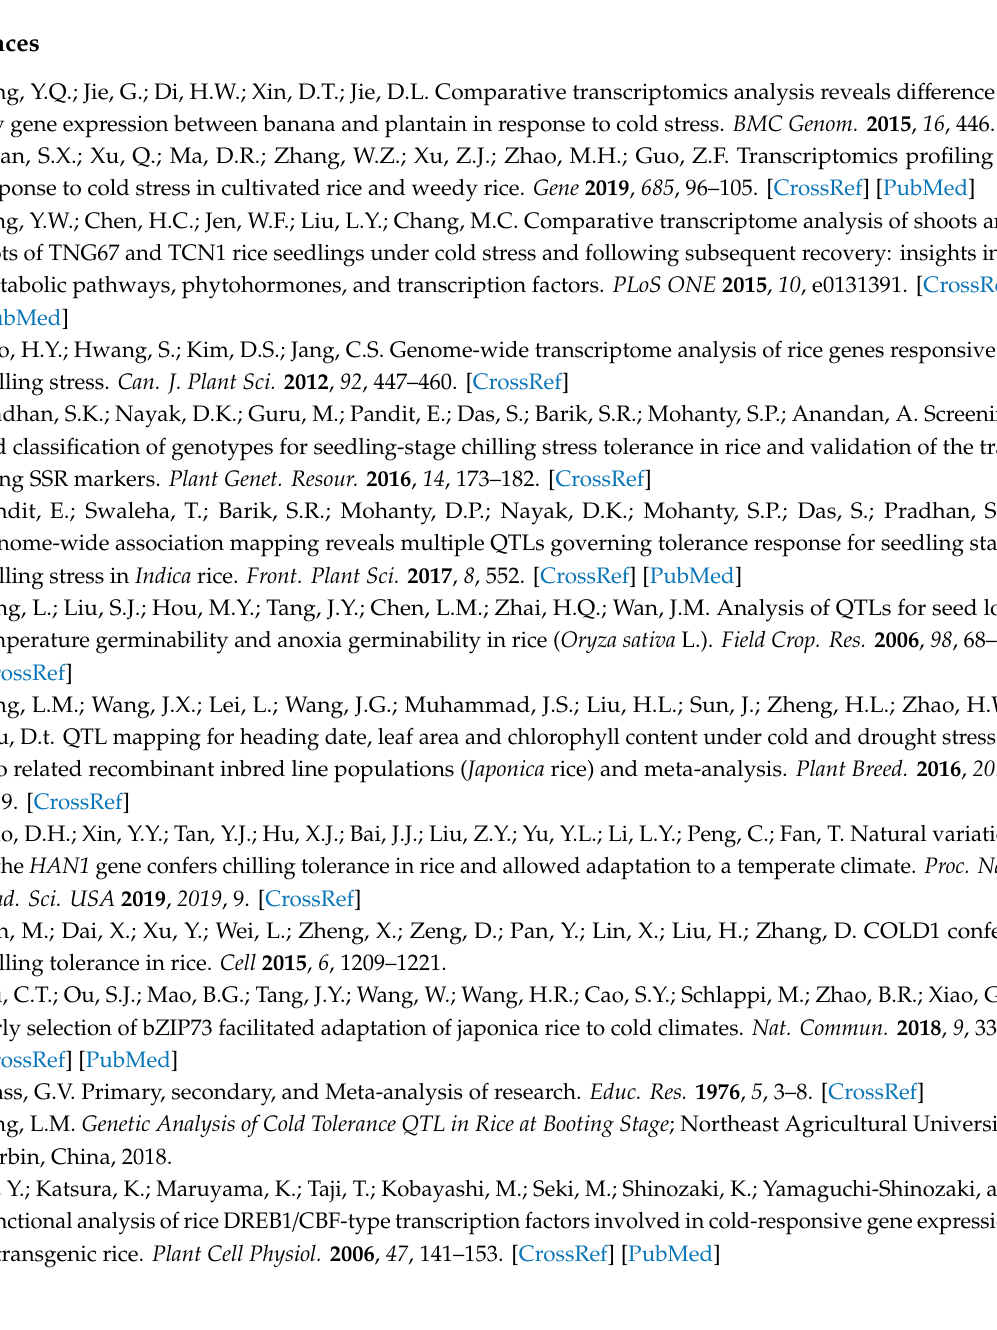
Table S1: Statistics and details of DEGs in this study; Table S2: Full-length nucleotide sequences of all DEGs; Table S3: The topGO result of DEGs; Table S4: The KEGG statistical result of DEGs; Table S5: Mapman enrichment result of DEGs; Table S6: Detailed information of Meta-QTLs; Table S7: Detailed information of DEGs in Meta-QTLs. Figure S1: KEGG term of phenylpropanoid biosynthesis (ko00940); Figure S2: KEGG term of plant hormone signal transduction (ko04075); Figure S3: KEGG term of plant-pathogen interaction (ko04626); Figure S4: KEGG term of circadian rhythm—plant